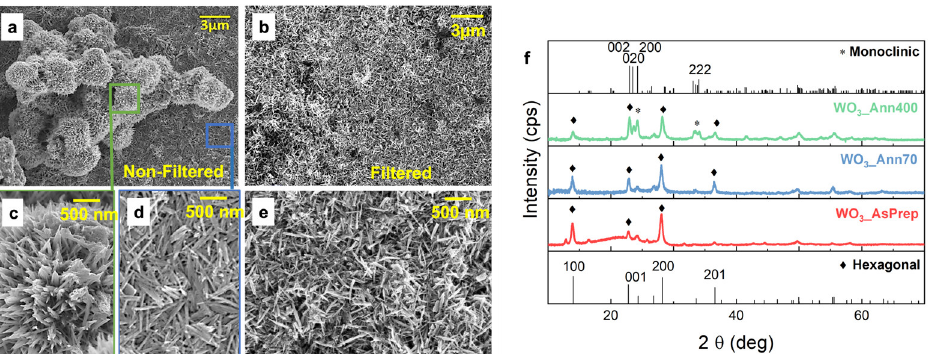
Figure 1. Low magnification SEM images of ( a ) NF and ( b ) F WO 3 powder; high-resolution SEM images of ( c ) urchin-like nanostructures and ( d ) nanorods present in the NF WO 3 powder and ( e ) nanorods present in the F WO 3 powder; ( f ) XRD patterns of WO 3 _AsPrep, WO 3 _Ann70 and WO 3 _Ann400 powders compared with the hexagonal and monoclinic characteristic patterns. The characteristic peaks are labeled depending on the crystalline planes, and hexagonal and monoclinic contributions are distinguished by using different symbols (rhombuses and circles, respectively).